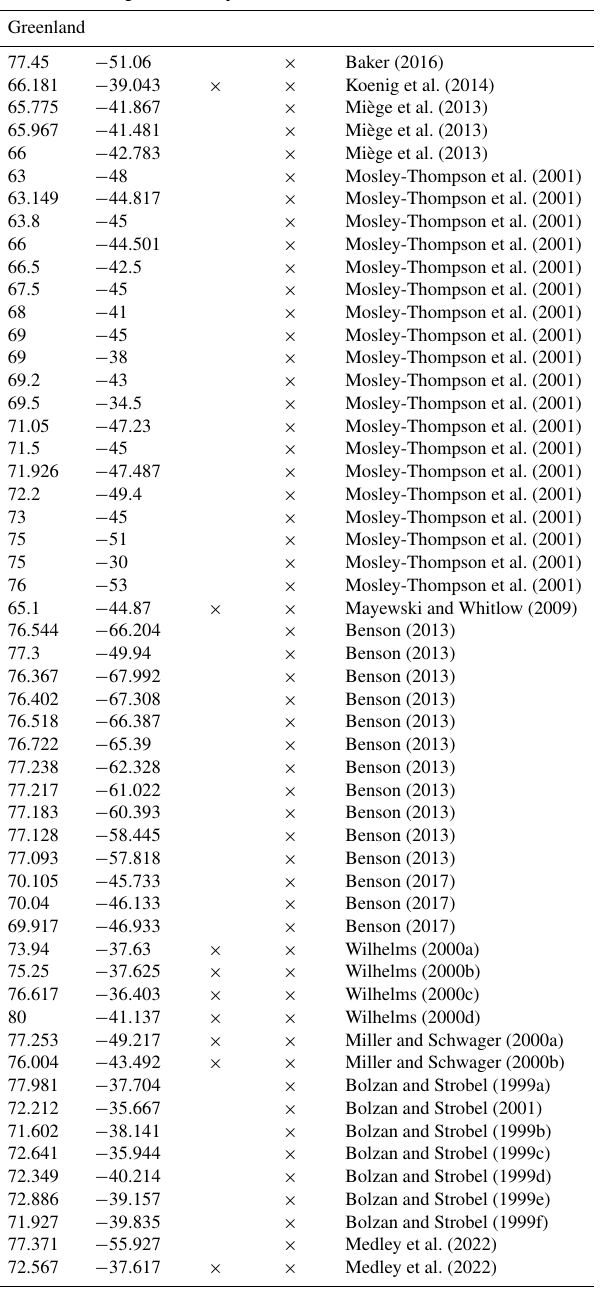
Table A1. The following tables list the cores, taken from Mont- gomery et al. (2018) and Medley et al. (2022), and their ci- tations. Those used for deep core calibration analysis (density of 830kgm − 3 ) and shallow core calibration analysis (density of 550kgm − 3 ) are marked in the corresponding “Deep” and “Shal- low” columns. Cores without a deep or shallow designation were used for model